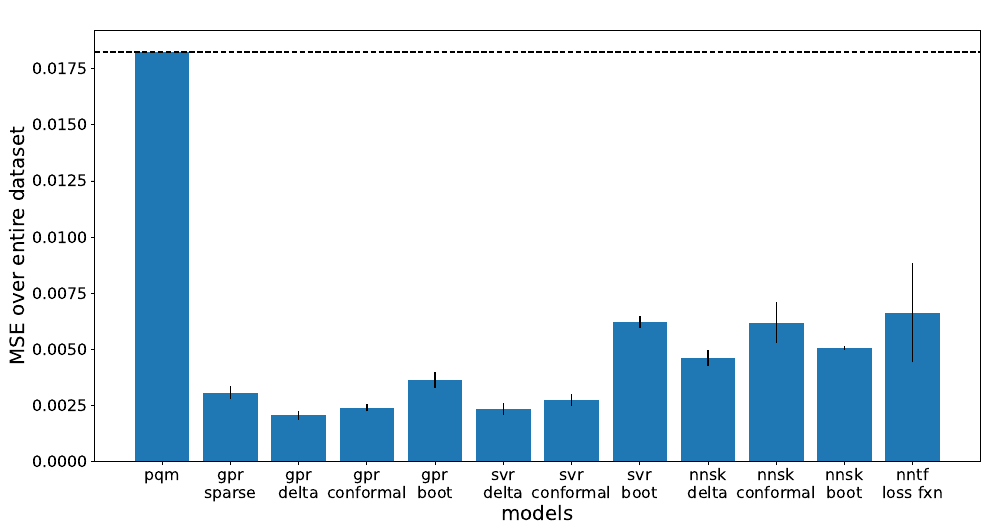
Figure 4. Performance comparison of models with different UQ models. PQM is presented for comparison as the left-most bar and the dotted